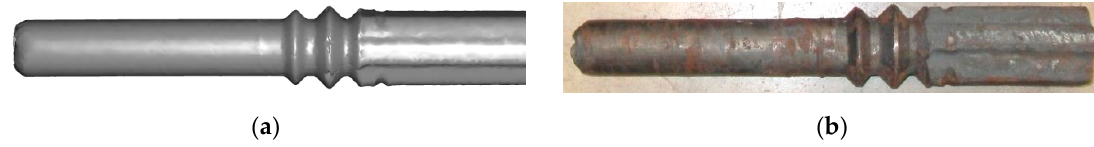
Figure 15. Changes in the shape of the workpiece during skew rolling of preforms obtained from scrap rail heads: ( a ) determined using FEM; ( b ) determined experimentally.